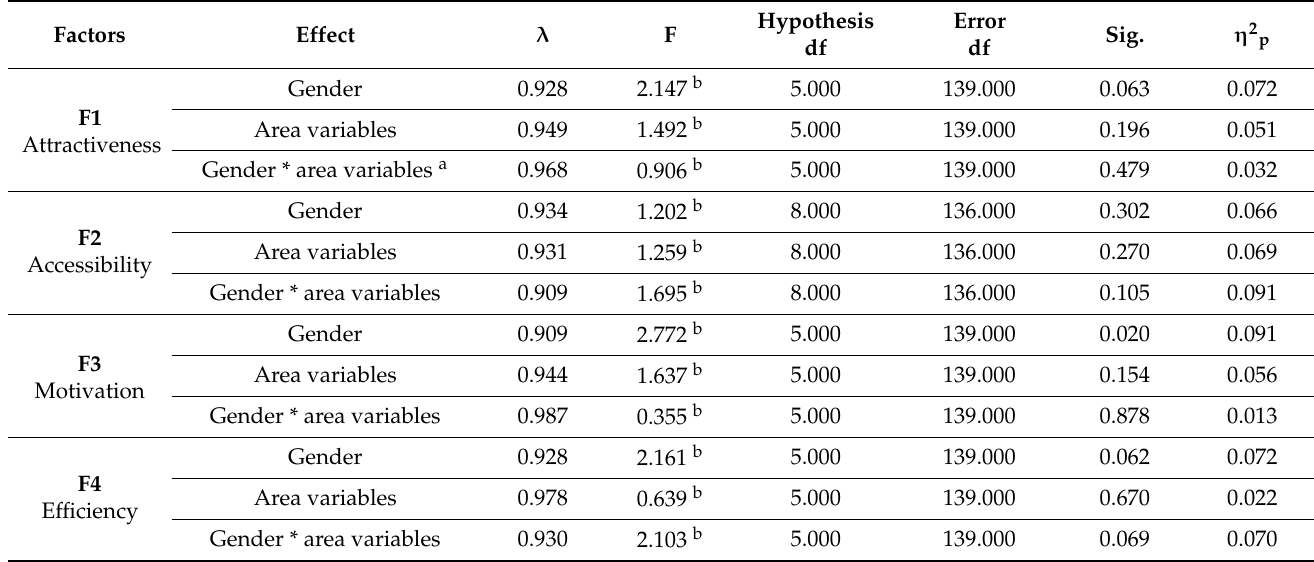
Table 2. Results of multivariate